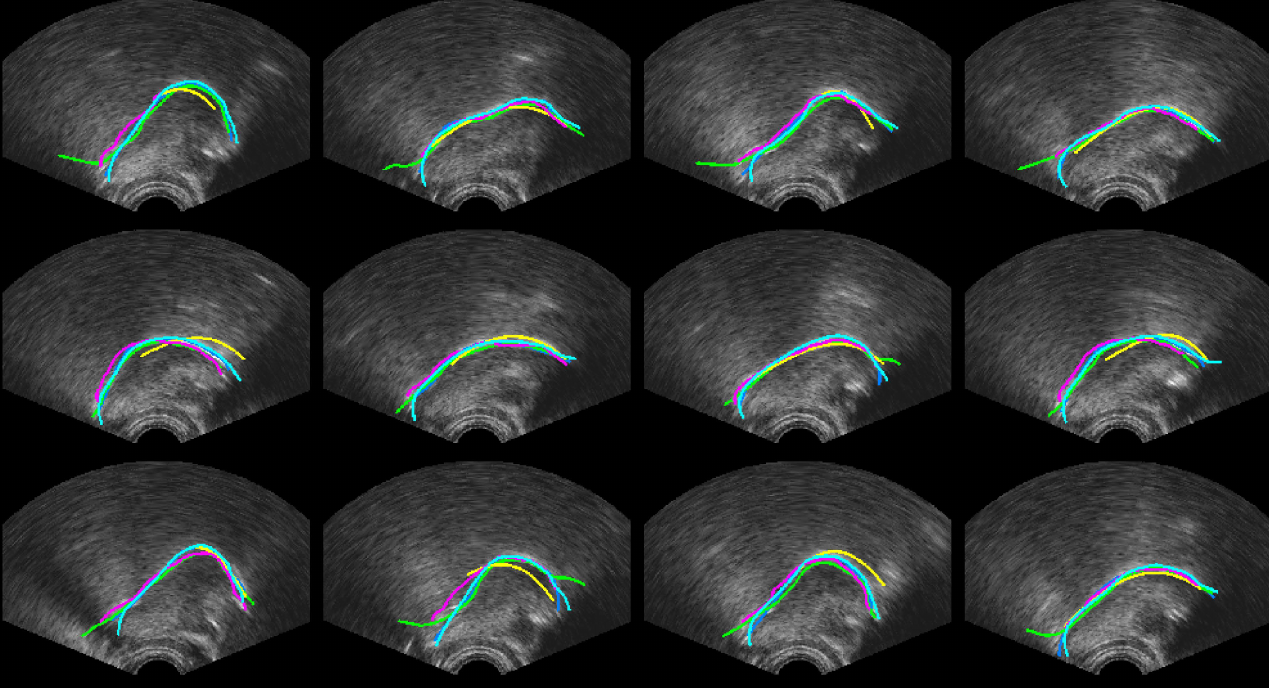
Figure 11. Speaker UXSSD03F; blue—hand-label; green—SLURP; yellow—MTracker; pink— DeepEdge;